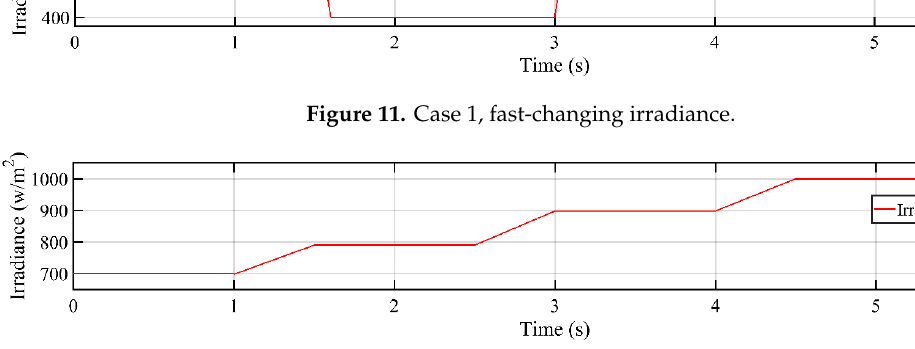
Figure 12. Case 2, continuously changing irradiance.